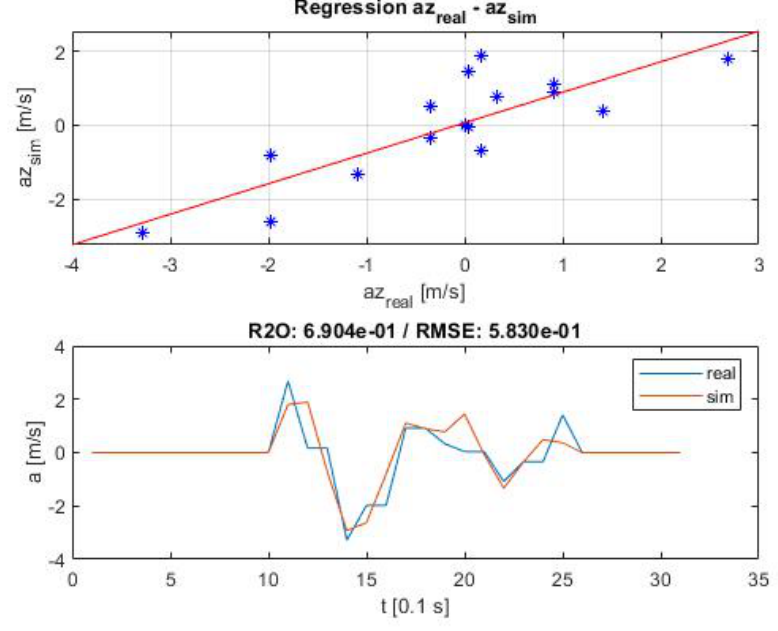
Figure A4. Validation of the z -acceleration in scenario 4 including ordinary R 2 and RMSE